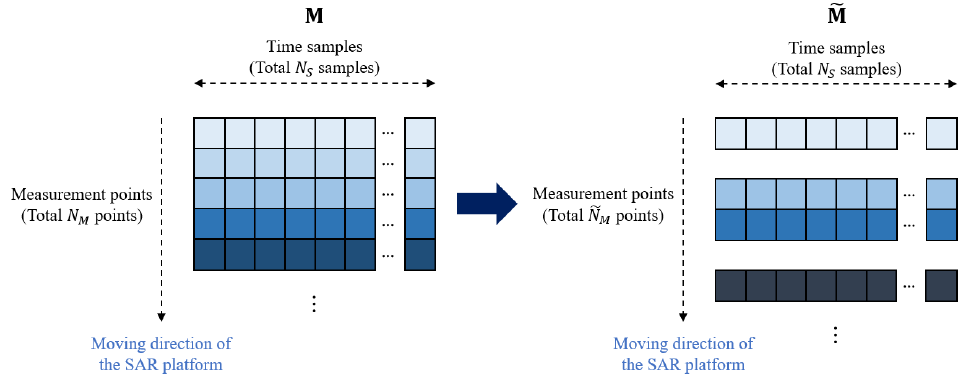
Figure 3. Regular and irregular data